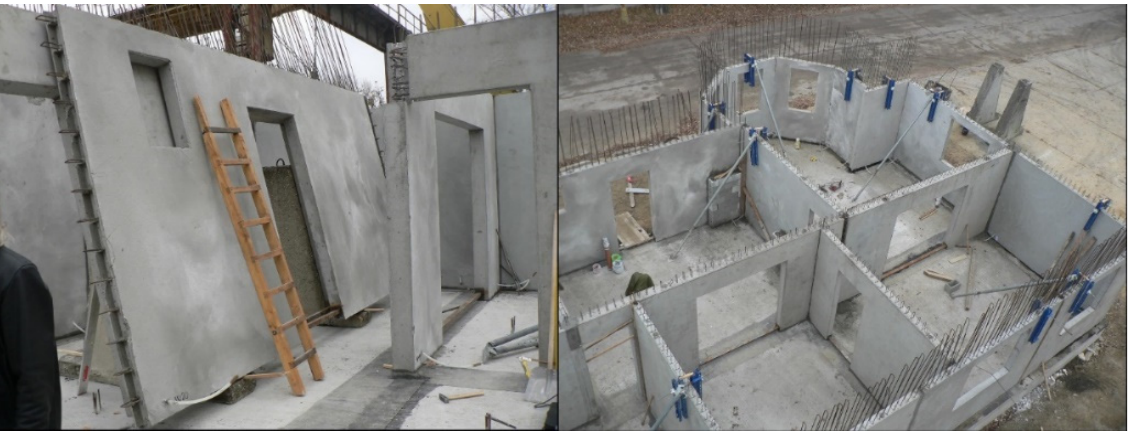
Figure 6. Prototype of prefabricated house IDA I—view of the innovative panels with built-in